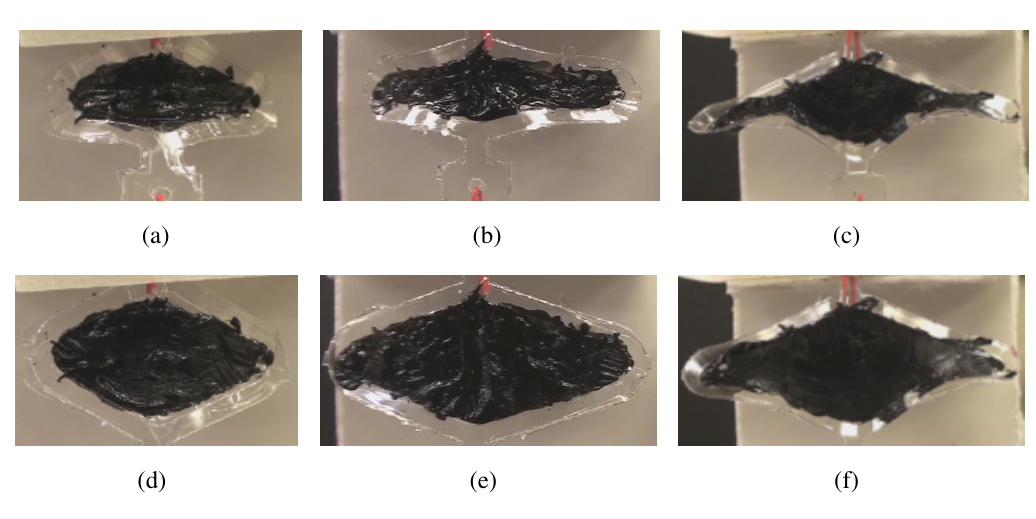
Figure 5. The dielectric elastomer minimum energy structure (DEMES) diamond actuators.